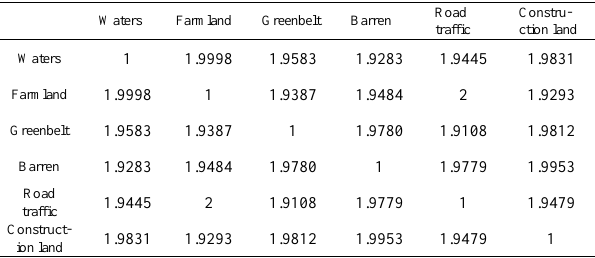
Table 3. The segregation of training samples